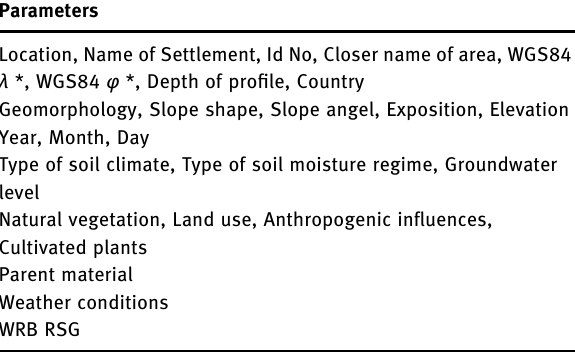
Table 3: List of queryable parameters Parameters